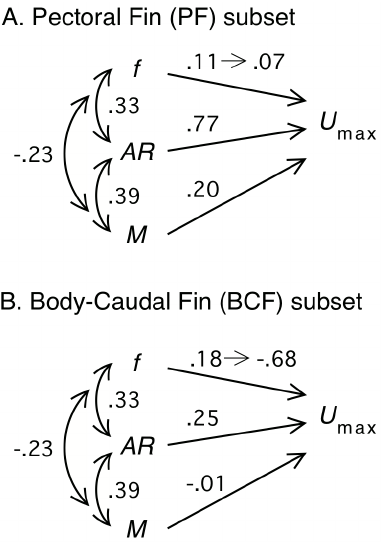
Figure 5. Path model of effect of predictor variables on maximum prolonged-swimming speed (log U max ). (A) pectoral fin (MPF) and (B) body and caudal fin (BCF) subset of coral reef fish species. Predictor variables are f (body fineness ratio), f 2 , AR (propulsive fin aspect-ratio), and log M (body mass). The linear and quadratic effects of f are combined to give the range of the effect from the f min to f max . The b coefficient (the number above the directed path) for each predictor is the model-averaged (standard partial regression) coeffi- cients as described in the text. Correlations among predictors are given next to the bi-directional